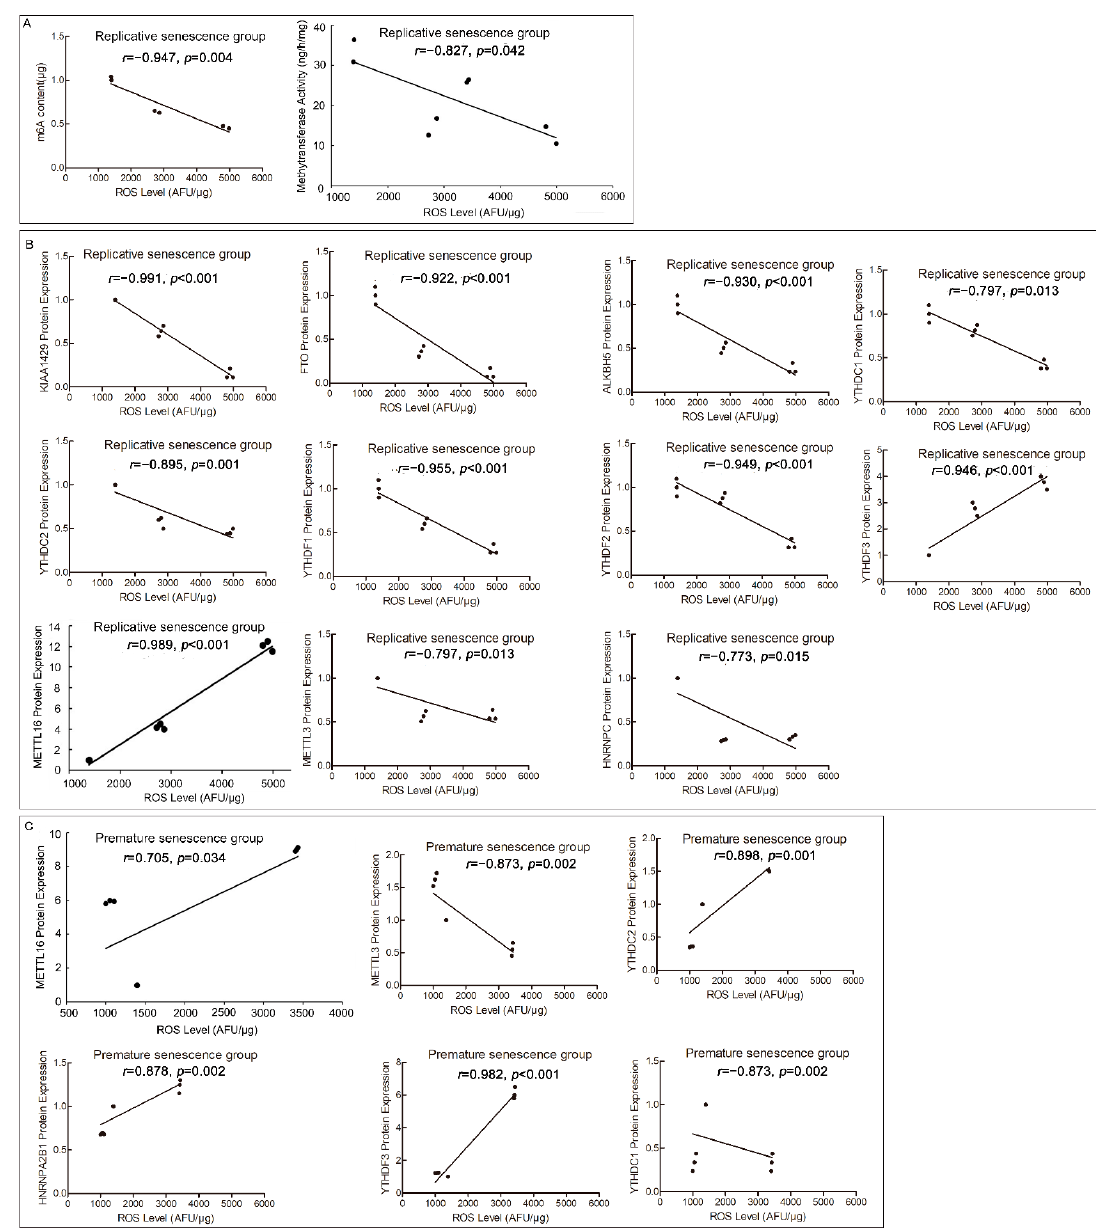
Figure 4. Correlation analysis of ROS and m6A RNA methylation indexes. ( A ) Correlation analysis of ROS with m6A contents and RNA methyltransferase activity from the 22PDL, 35PDL, and 49PDL group. ( B ) Correlation analysis of ROS with RNA methyltransferases, demethylases, and binding proteins in replicative senescence group from the 22PDL, 35PDL, and 49PDL groups. ( C ) Correlation analysis of ROS with RNA methyltransferases, demethylases, and binding proteins in premature senescence group from the 22PDL, PSi, and PSp groups,